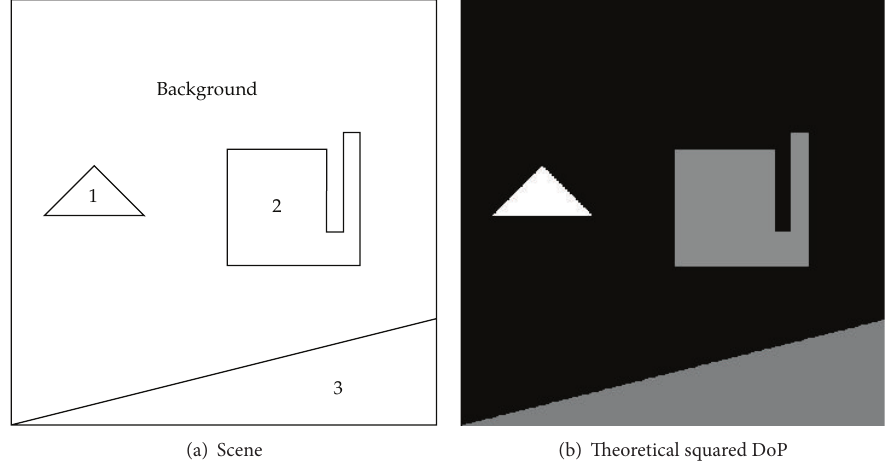
Figure 4: Composition of the scene used to generate synthetic polarimetric low flux images and associated theoretical squared DoP.